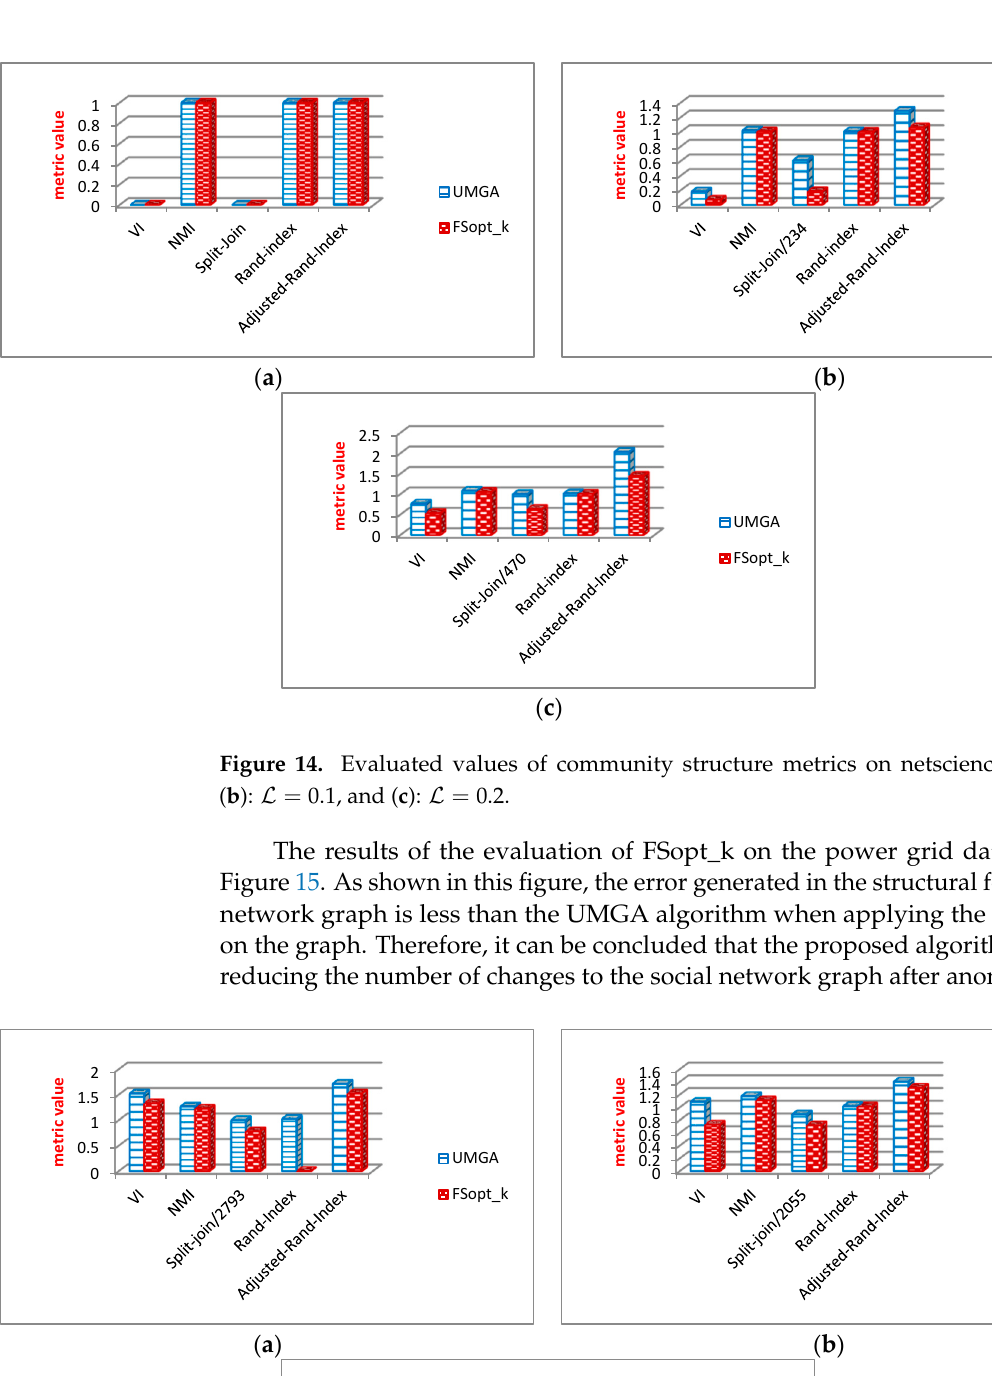
23 of 31 ( c ) Figure 13. Evaluated values of community structure metrics on Dolphins for ( a ): ℒ = 0.05 , ( b ): ℒ = 0.1 , and ( c ): ℒ = 0.2 .